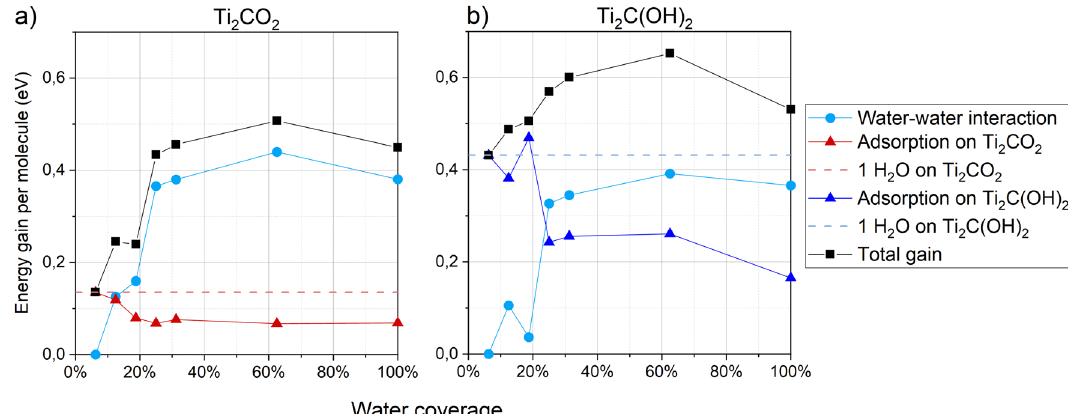
Fig. 6 Energy gain per molecule as a function of the water coverage for a Ti 2 CO 2 and b Ti 2 C(OH) 2 . Two contributions to the total energy (black line) are considered. The interaction between water molecules is in light blue. The interaction between the water layer and the substrate is colored depending on the type of termination. The dashed line indicates the interaction value for a single water molecule, corresponding to a coverage of 6%. Solid lines between points are guides to the